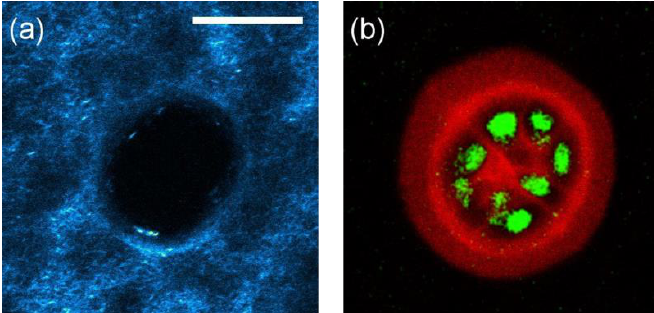
Fig. 5 SHG image (a) and fluorescence image (b) of an aggregation of round cells. The red colored regions indicate immunostained type II collagen, and the green colored regions indicate cytoplasm stained with calcein AM. Scale bar = 50 